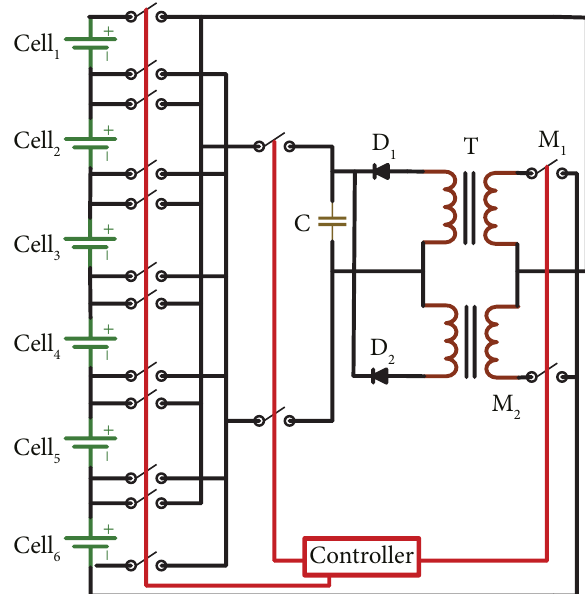
Figure 10: Push-pull converter-based